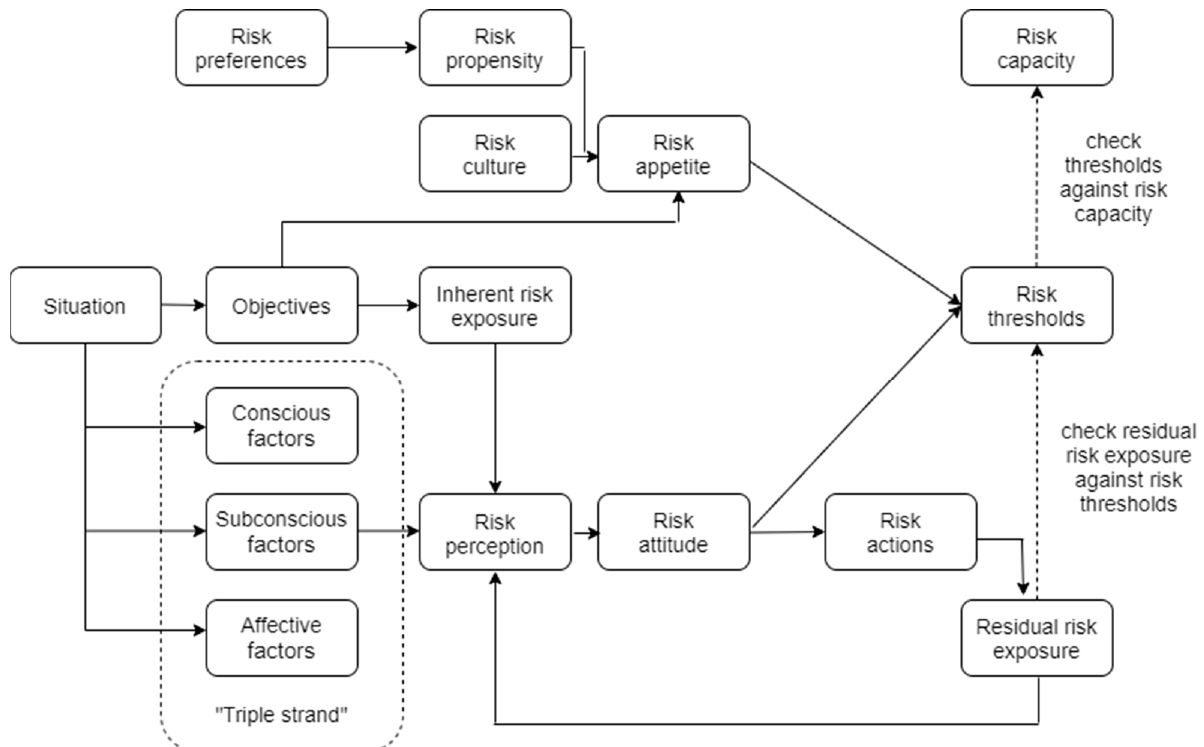
Figure 4. The Risk Appetite–Risk Attitude (RARA) model. An adaptation based on source [23].